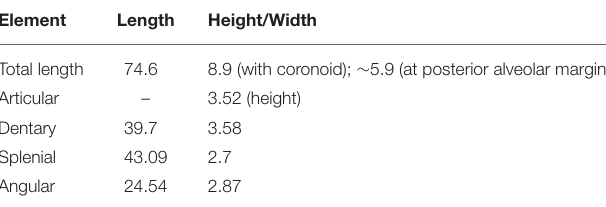
TABLE 2 | Measurements (in mm) of the mandibular bones of PIMUZ T 1559.